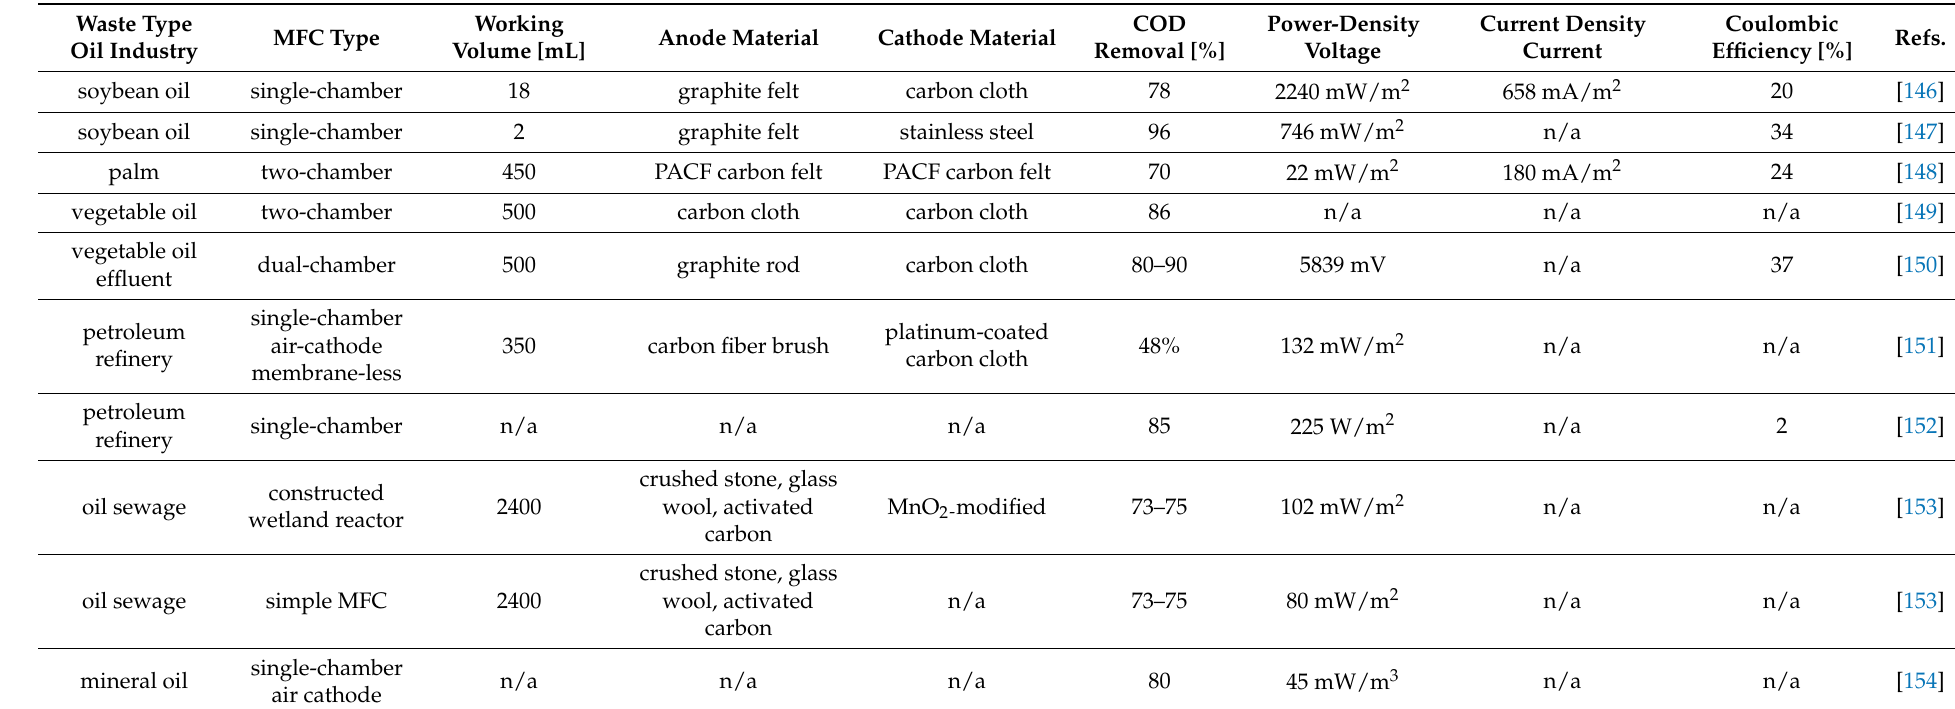
Table A5. Summary of studies reporting use of oil industry waste in